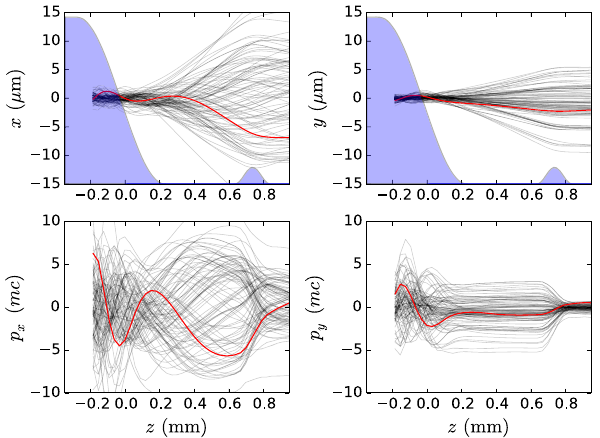
FIG. 5. Results of a standard PIC simulation for the laser- plasma lens. Upper panels: Density profile of the two jets (blue curves) and evolution of the transverse coordinates x (left panel) and y (right panel) for some of the accelerated electrons (black lines). (In the simulation the laser is polarized along x .) Lower panels: Evolution of the transverse momenta p x (left panel) and p y (right panel) for the same electrons. For more clarity, the trajectory of one of these electrons has been singled out and colored in